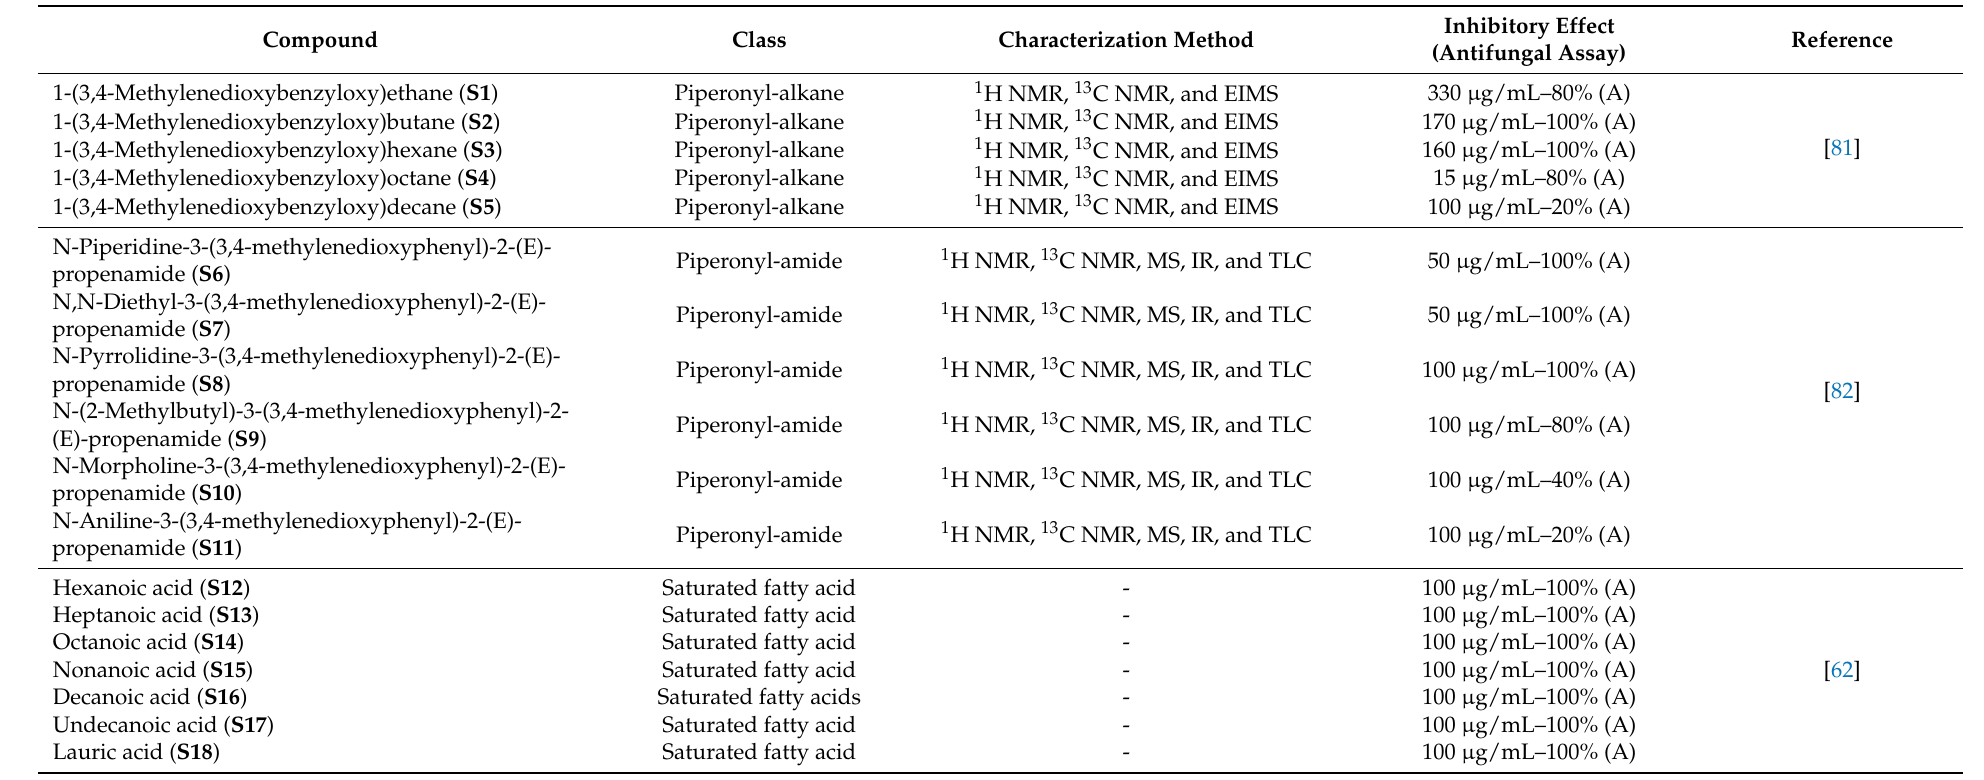
Table 4. Synthetic compounds with potential antifungal effects against Leucoagaricus gongylophorus by in vitro